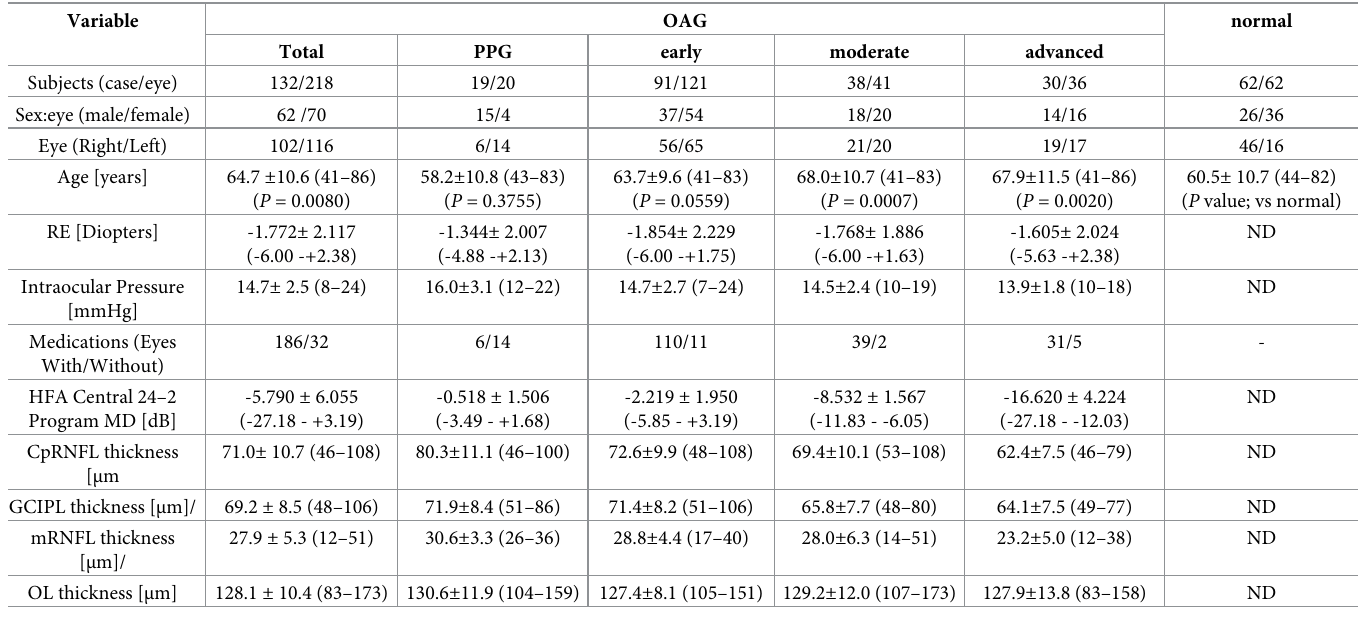
Table 1. Demographic data of all